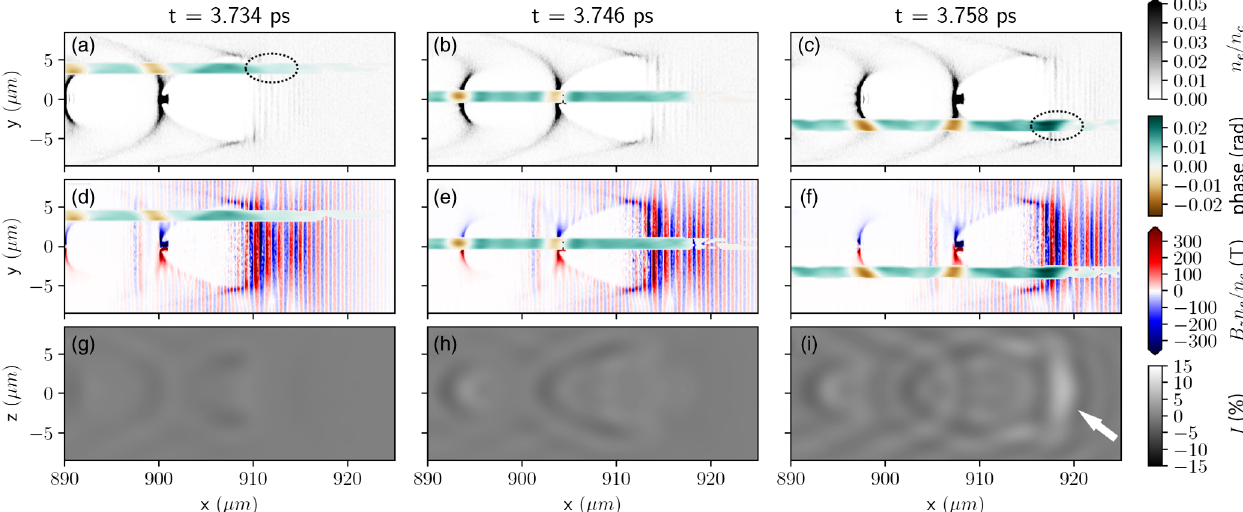
FIG. 5. (a) – (c) Normalized plasma density with overlay of probe ’ s relative phase in radians. (d) – (f) Scaled magnetic fields with phase overlay. (g) – (i) Relative irradiance modulation of simulated shadowgram in %. The H-pol probe propagates in the − y direction and its FWHM temporal extent is coincident with the green/yellow phase colormap. Shadowgrams (g) – (i) are created using only the phase accumulated up to the indicated probe position. Plots (a) – (f) correspond to xy planes at z ¼ 0 μ m. The white arrow denotes strong brightness modulation described in the